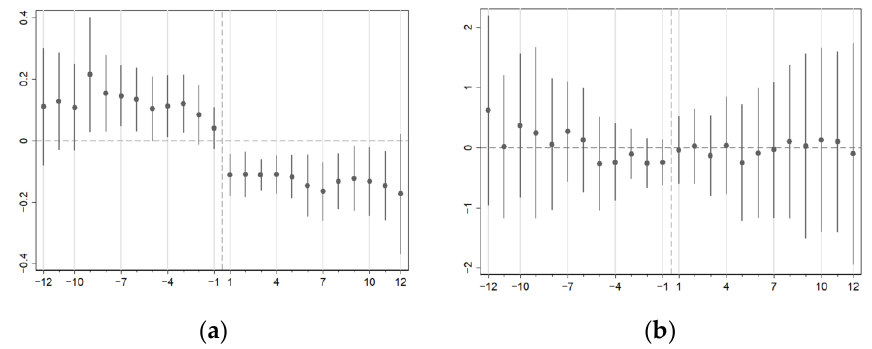
Figure 2. ( a ) Dynamic effects on medical costs; ( b ) Dynamic effects on LOS. Horizontal axis represents the month relative to the reform and vertical axis is the change in reform effects. Medical costs are in natural logarithm. We use poisson model for LOS as a discrete count variable. Standard errors cluster at hospital-time level.